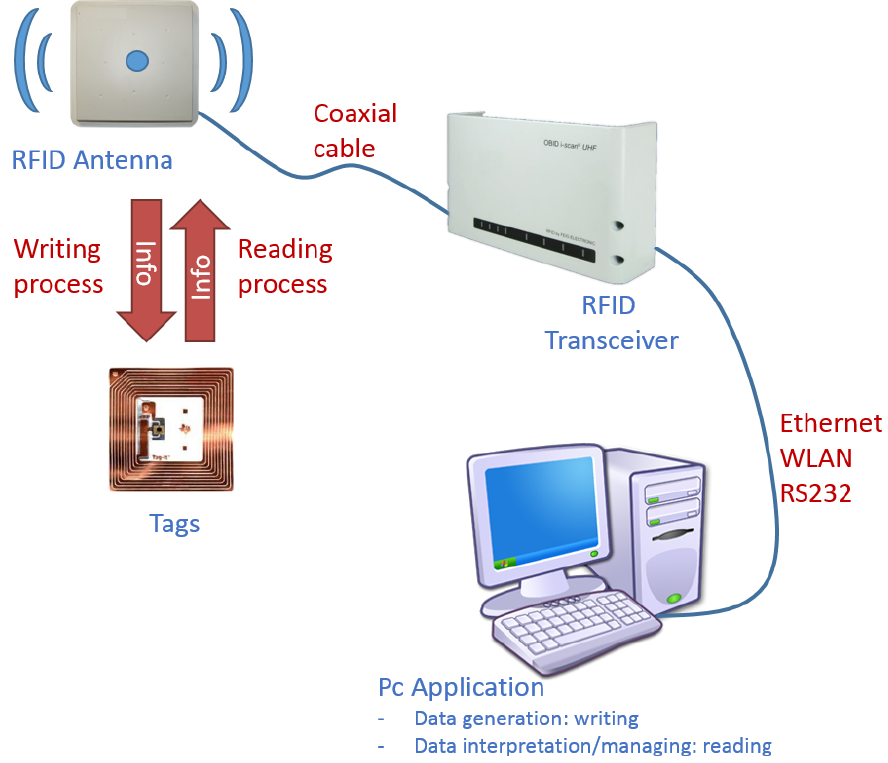
Figure 1. Example of an RFID